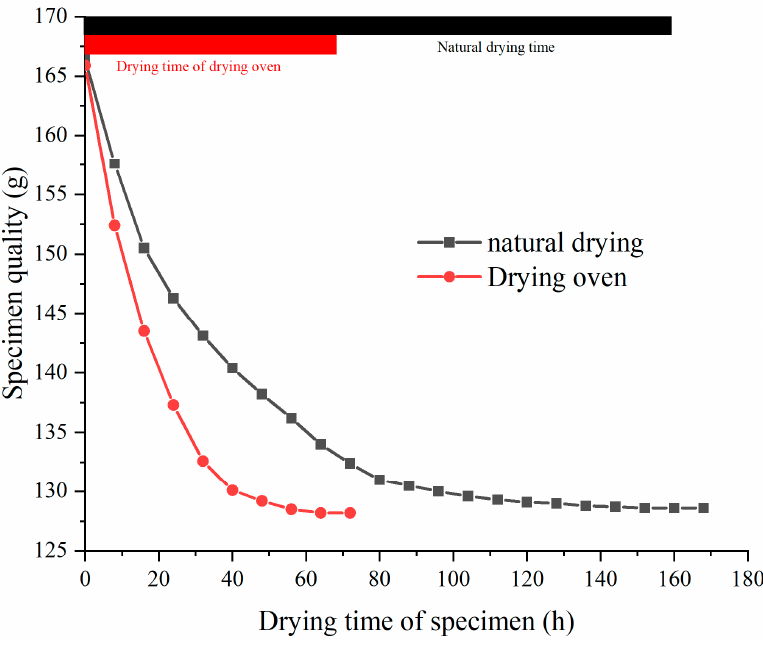
Figure 2. Drying durations of the specimens.